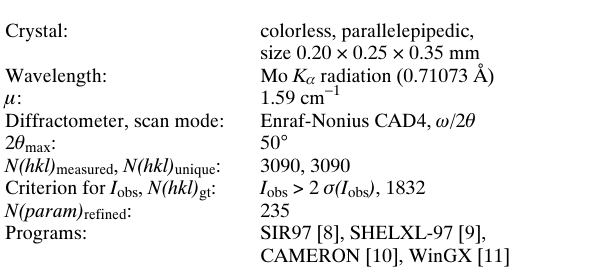
Table 2. Atomic coordinates and displacement parameters (in Å 2 ) . Table 1. Data collection and